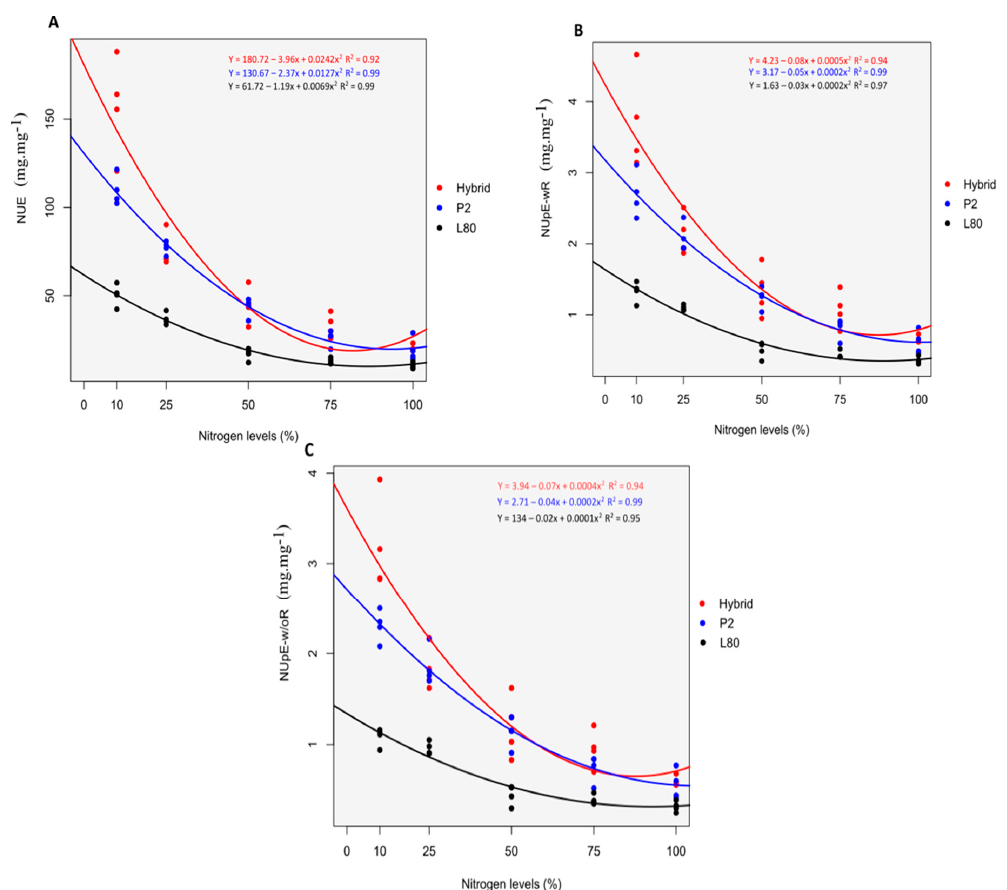
Figure 3. Performance of the popcorn genotypes under five different N levels for NUE ( A ), NUpE ‐ w/oR ( B ) and NUpE ‐ wR ( C ) at the V6 stage.